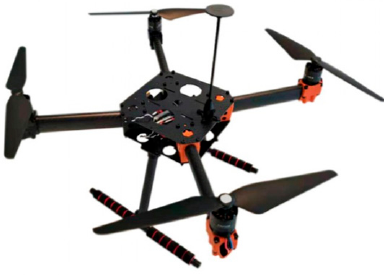
Figure 1. EDU450 carbon fiber frame.